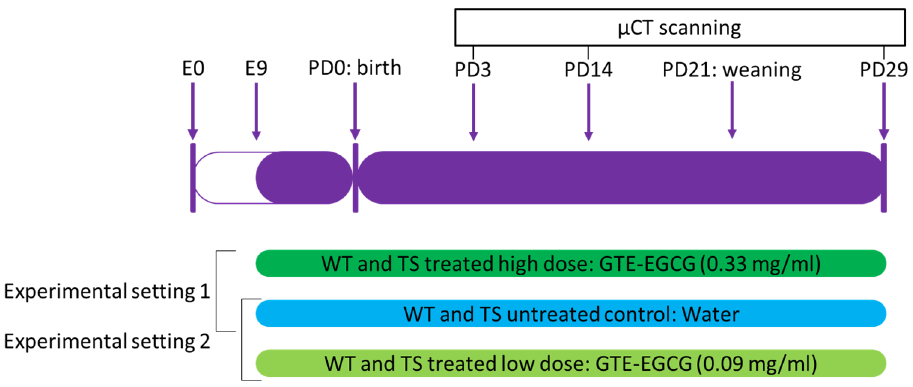
Figure 1. Experimental overview. Wildtype and Ts65Dn mice were scanned with in vivo µ CT from birth to juvenile stages at three different stages of development (postnatal day (PD) 3, PD14, and PD29) to longitudinally follow the skeletal development. Four litters of mice were untreated